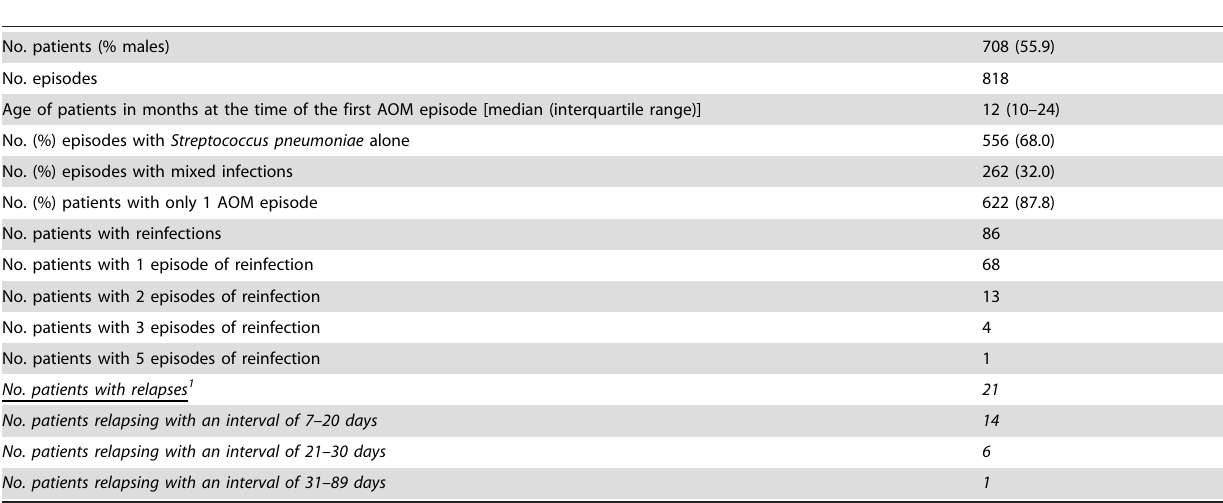
Table 1. General characteristics of patients and pneumococcal acute otitis media (AOM)